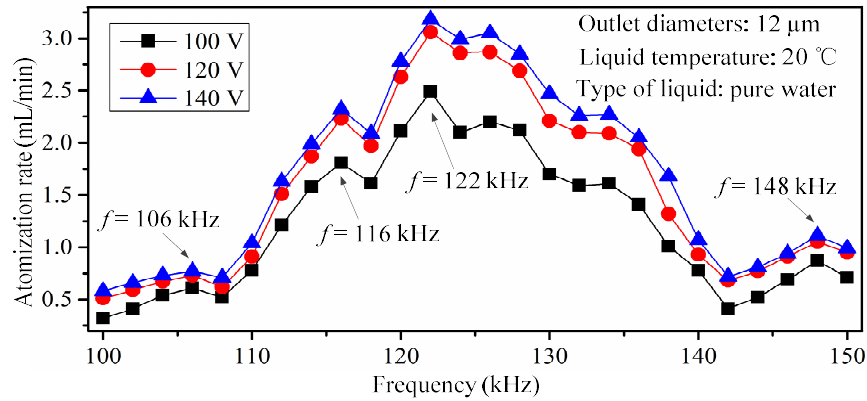
Figure 9. Relationship between atomization rate and frequency. Table 2. Atomization rates at di ff erent resonance frequencies, when the driving voltage is 120 V. Frequency